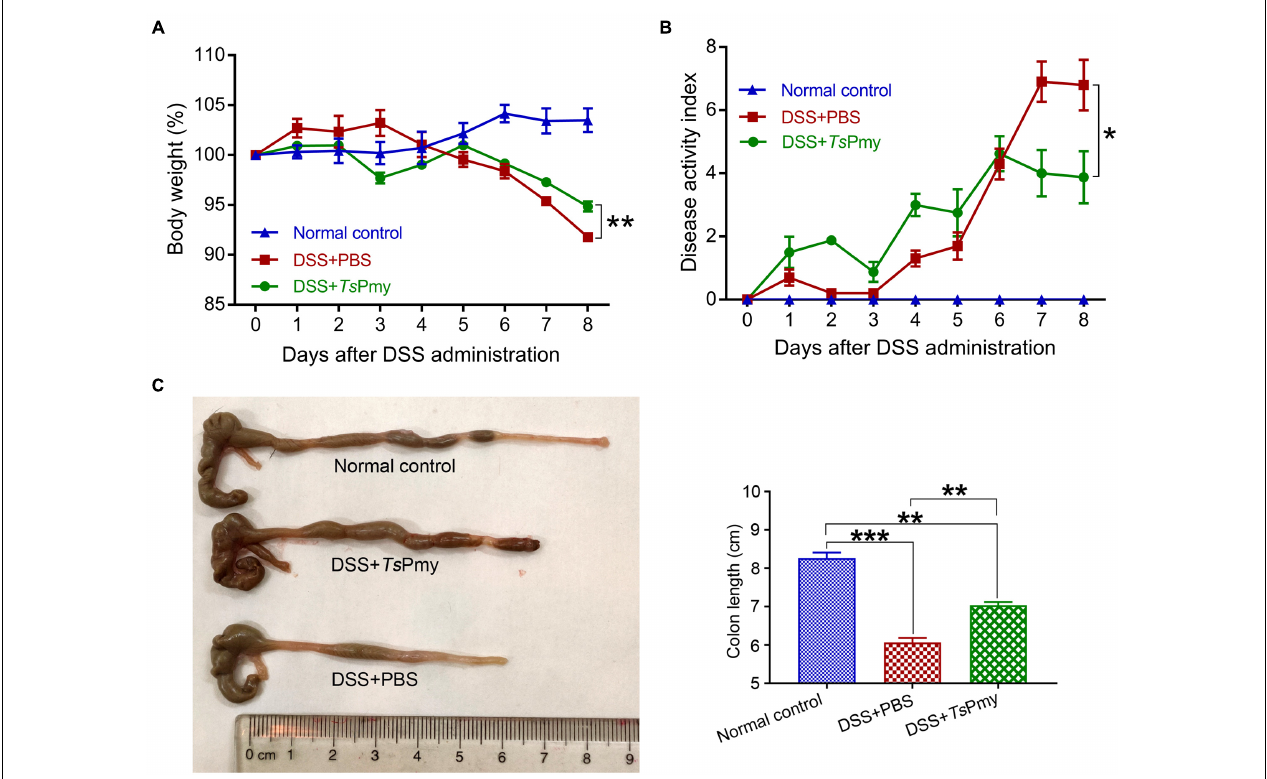
FIGURE 1 | Treatment with r Ts Pmy alleviates clinical manifestations and colon shortening in DSS-induced acute colitis. Each mouse was treated with 20 µ g of r Ts Pmy three times before being challenged with 3% DSS for 6 days. (A) Body weight changes (relative to initial weight) ( n = 5). (B) The whole diseases activity index changes ( n = 5). (C) Representative colons from each group are shown on the left; the average colon length from each group is shown on the right ( n = 5). The data represent the mean ± SEM. * p < 0.05, ** p < 0.01, *** p <